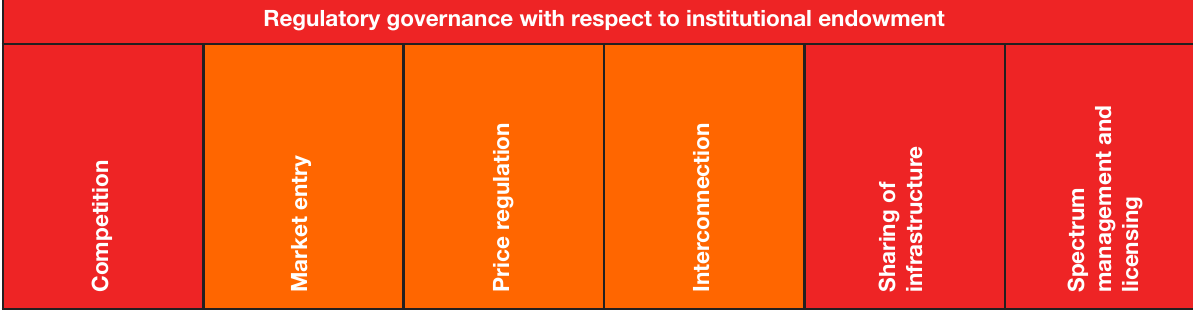
FIGURE 4: PERCEPTIONS OF EFFECTIVENESS OF REGULATORY INCENTIVES Regulatory governance with respect to institutional